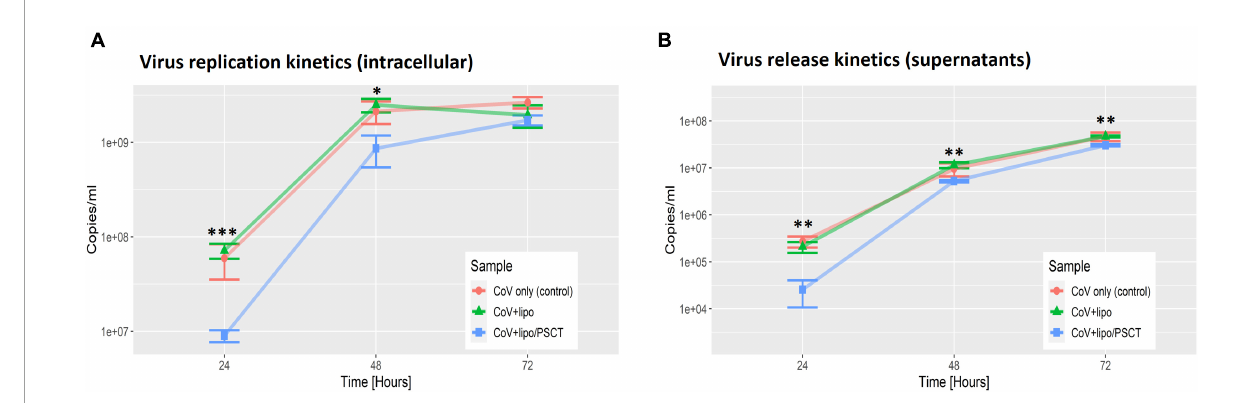
FIGURE3 SARS-CoV-2 replication is decreased at 24–72 h p.i. by PSCT transfection as compared to mock treatment. Vero E6 cells were infected with SARS-CoV-2 viral stock at low MOI and the cultures were treated with liposome-encapsulated PSCT (250 ng/well), mock treatment, or left untreated, as detailed in the results section. The cell lysates (A) and supernatants (B) were collected at 24, 48, and 72 h p.i., and used to determine SARS-CoV-2 genome copies/ml by multiplex qPCR. (A) Depicting SARS-CoV-2 intracellular replication inhibition in the PSCT treatment group as compared to mock treated and untreated control cultures at the various time points. (B) Depicting significant inhibition of viral genome release into the cell-culture supernatants by PSCT treatment during the first 72 h p.i., as compared to mock treatment ( p < 0.01). Data shown represent the mean ± SEM of one representative experiment out of three performed in triplicates. Statistical analysis was performed by the LME model ( ∗ p < 0.05, ∗∗ p < 0.01, ∗∗∗ p < 0.001).